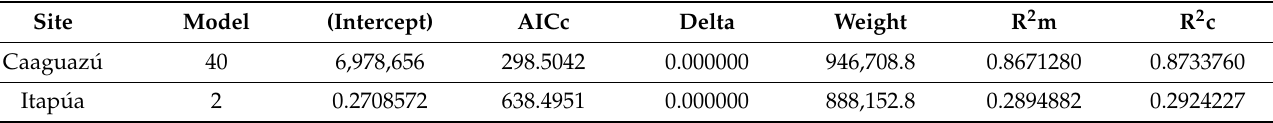
Table 3. Plausible models for the growth of the planted species in the two agroforestry experiments.